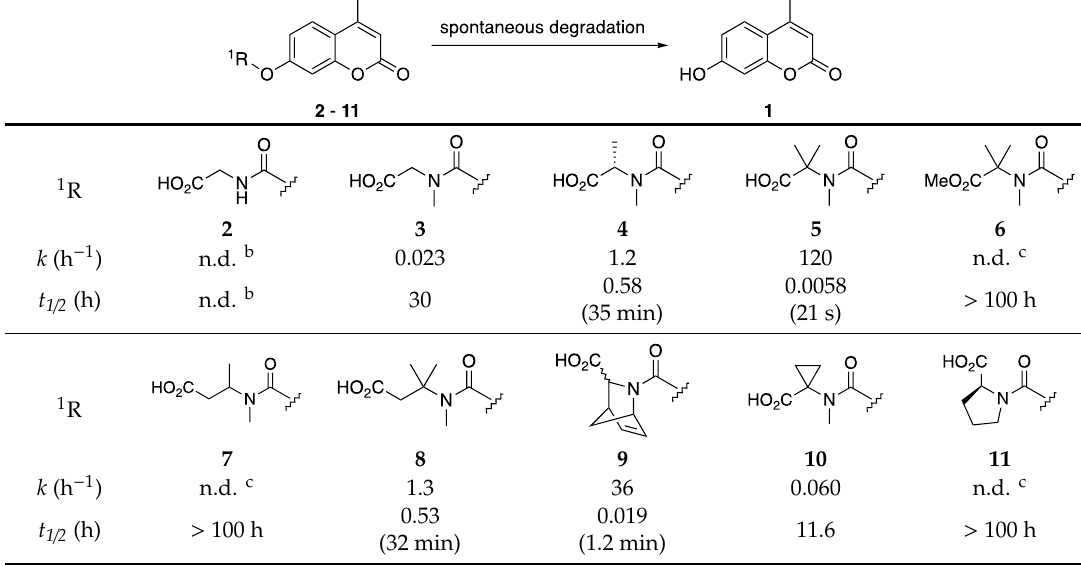
conditions: [probe] = 5 μM, 50 mM HEPES, pH 7.4, 37 °C, λ ex = 320 nm. b Not determined due to instability of the probe under measurement conditions. c Not determined. measurement conditions. c Not determined.